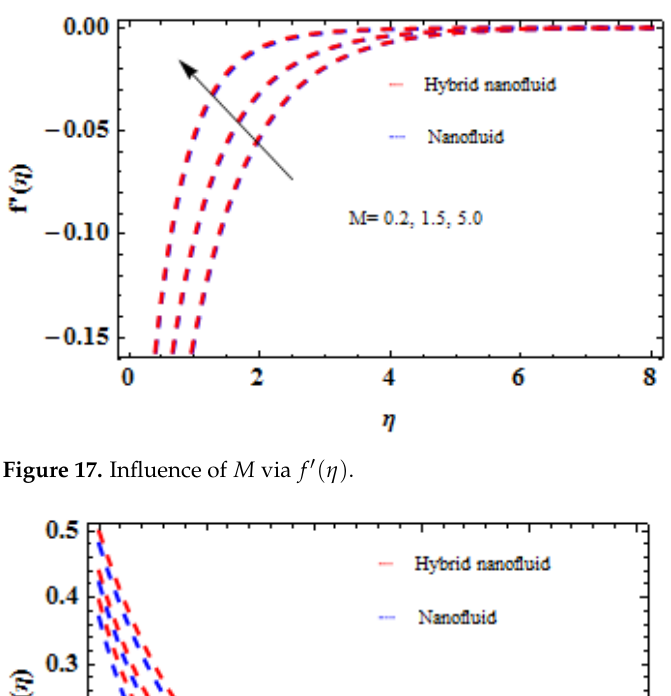
Figure 16. Influence of 𝐿 1 via 𝑓′(𝜂) .